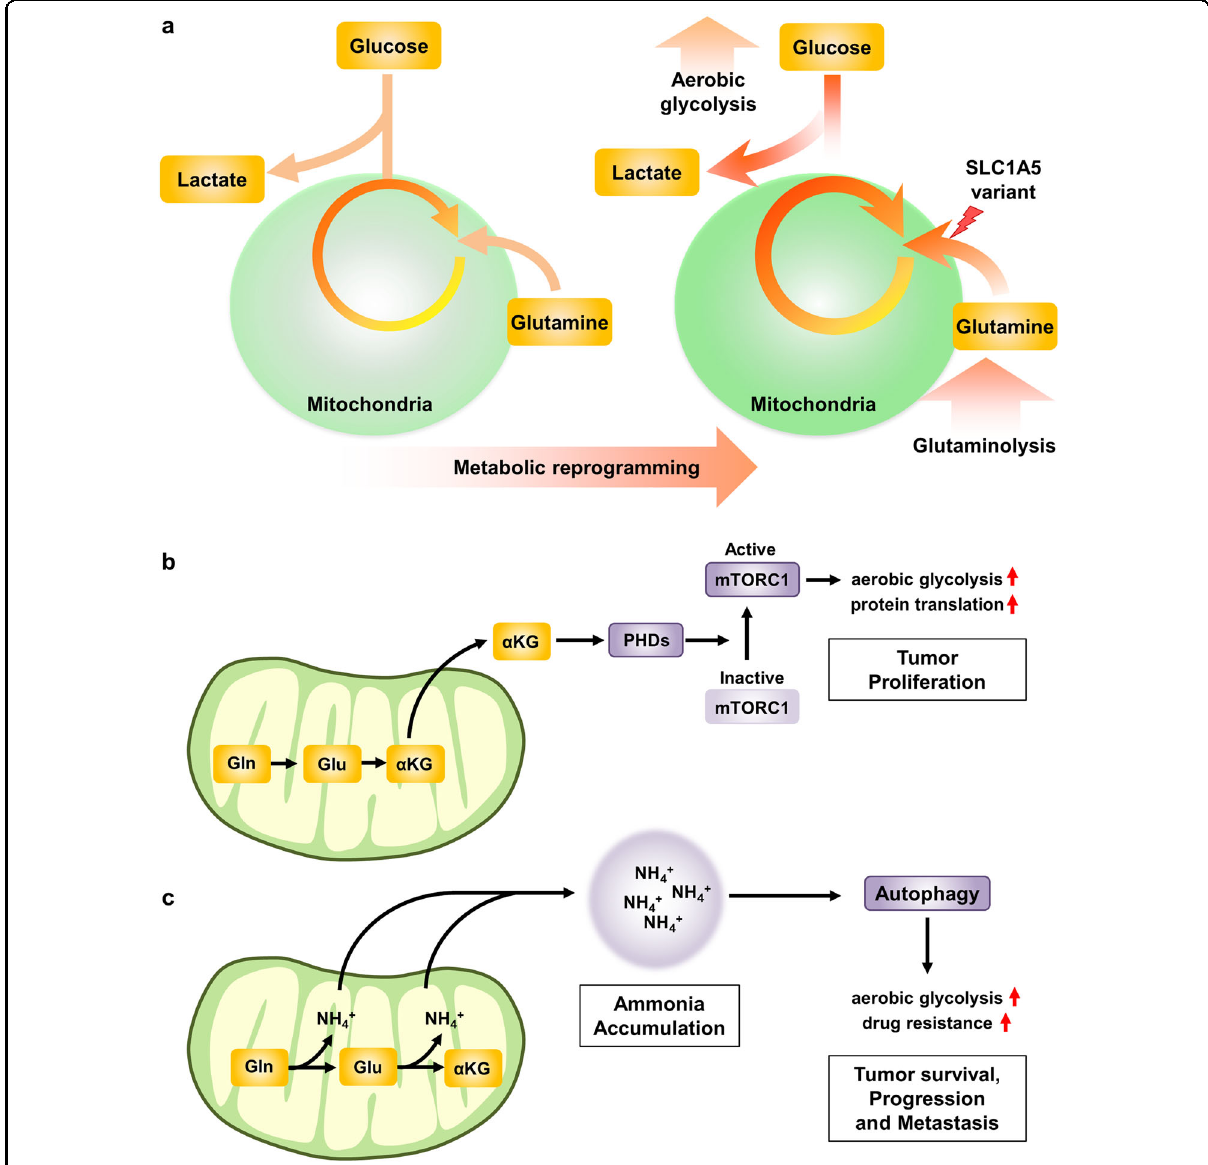
Fig. 6 Metabolic reprogramming induced by glutamine metabolism. a Aerobic glycolysis is a hallmark of cancer metabolism. During this process, most glucose-derived pyruvate is secreted extracellularly as lactate, and glutamine becomes a conditionally essential amino acid. Glutaminolysis sustains mitochondrial function, supplying TCA cycle metabolites such as α KG and generating diverse biomolecules, including NEAAs, NADPH, and nucleotides. Increased glutamine fl ux into the mitochondrial matrix via the SLC1A5 variant can enhance glutaminolysis and lead to metabolic reprogramming toward enhanced aerobic glycolysis. b Glutamine-derived α -KG activates the mTORC1 signaling pathway, resulting in aerobic glycolysis and protein translation, which are crucial for tumor proliferation. c During glutaminolysis, ammonium ions are generated via a deamidation reaction catalyzed by glutaminase and glutamate dehydrogenase. Most ammonium ions are used as a nitrogen source for nucleotide biosynthesis and are disposed of via the urea cycle, but an excess of ammonium ions promotes autophagy. Augmented autophagy is associated with drug resistance by enhancing aerobic glycolysis and is involved in cancer cell survival, progression, and metastasis. Gln glutamine, Glu glutamate, α - KG a-ketoglutarate, PHD prolyl